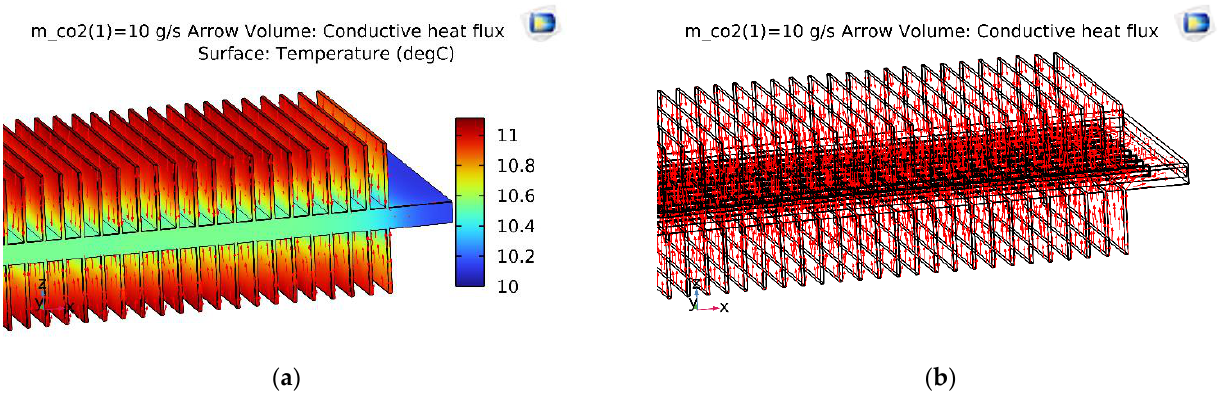
Figure 9. The temperature and conductive heat flux of the straight finned flat tube of the first pass.